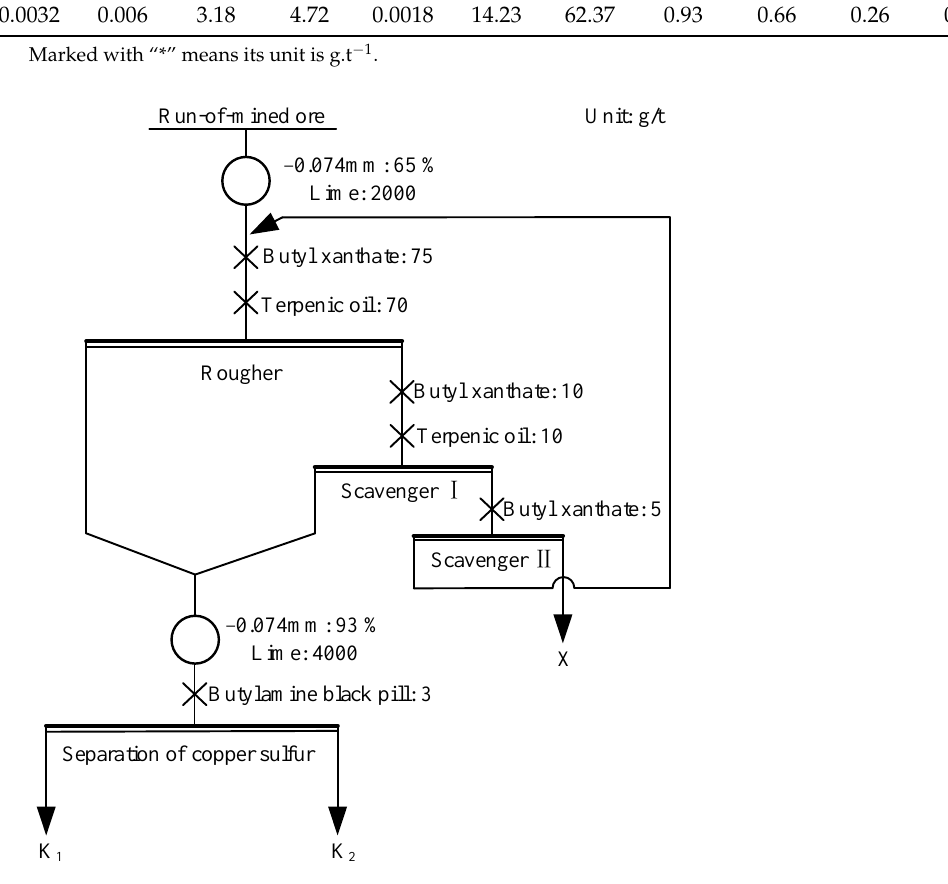
Figure 13. Flowsheet of closed-circuit test. Table 4. The results of closed-circuit test.